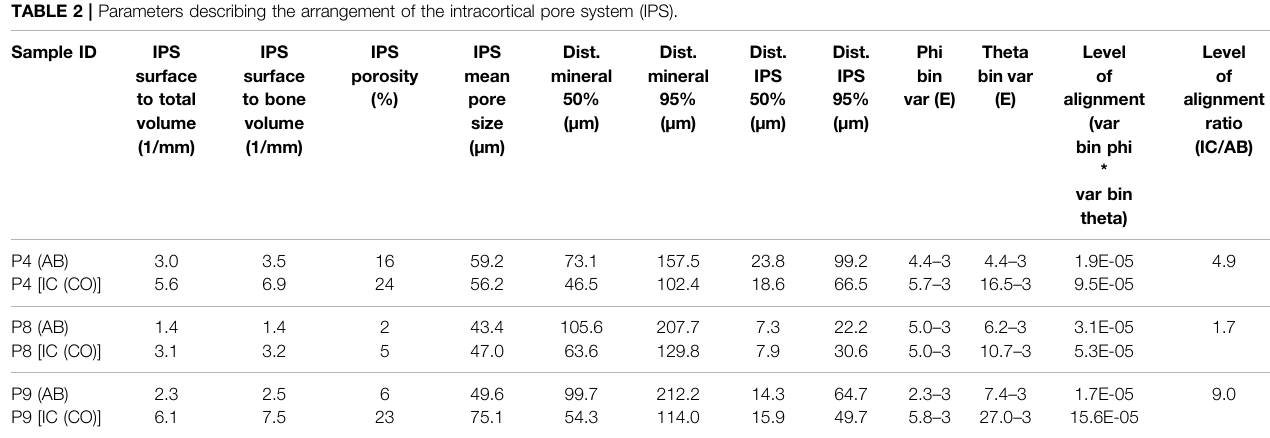
TABLE 2 | Parameters describing the arrangement of the intracortical pore system